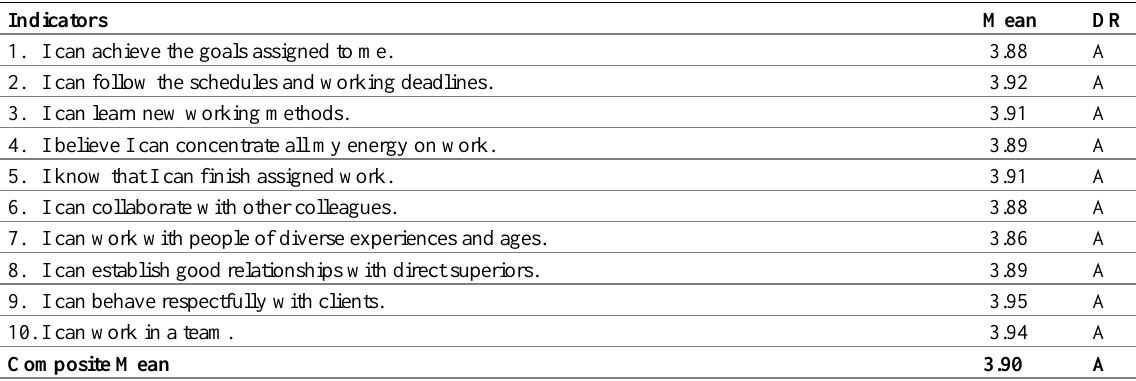
Table 7: The Work Self-Efficacy of